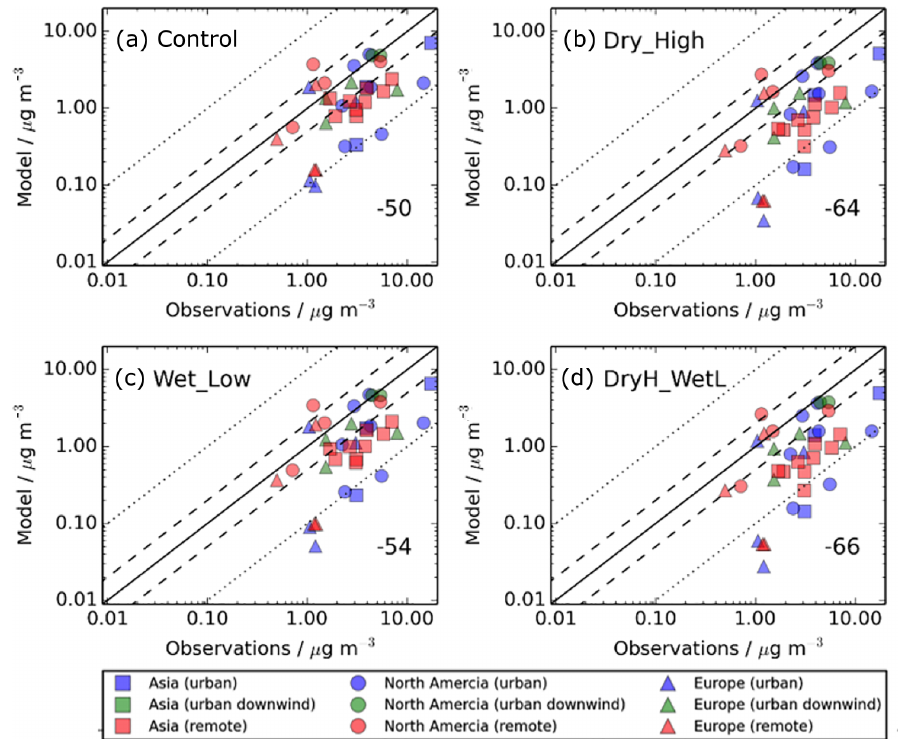
Figure 4. Simulated versus observed surface SOA concentrations (µgm − 3 ) for (a) Control, (b) Dry_High, (c) Wet_Low, and (d) DryH_WetL simulations, described in Table 3. Observations, originally compiled by Zhang et al. (2007), for the time period 2000–2010, are classified by site type – urban (blue), urban downwind (green), or remote (red) – and continent – Asia (squares), North America (circles), and Europe (triangles). Observed oxygenated OA is assumed to be comparable to simulated SOA. The 1 : 1 (solid), 1 : 2 and 2 : 1 (dashed), and 1 : 10 and 10 : 1 (dotted) lines are indicated. Numerical values in the bottom right of each panel indicate the normalised mean bias (%).